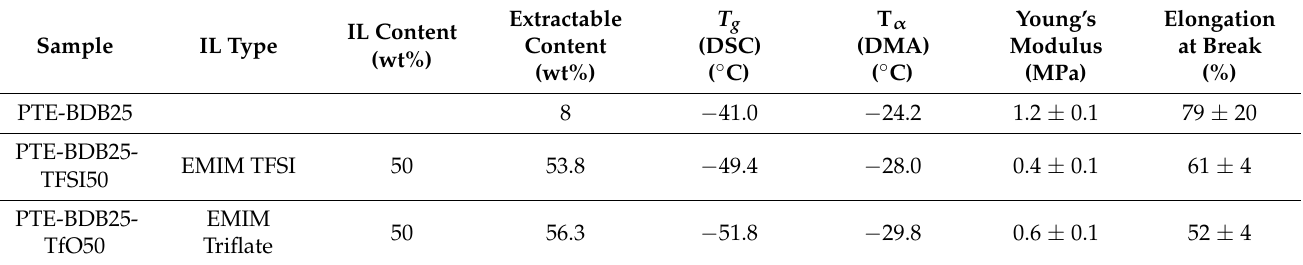
Table 2. Compositions and details of the PTE-BDB-IL samples.